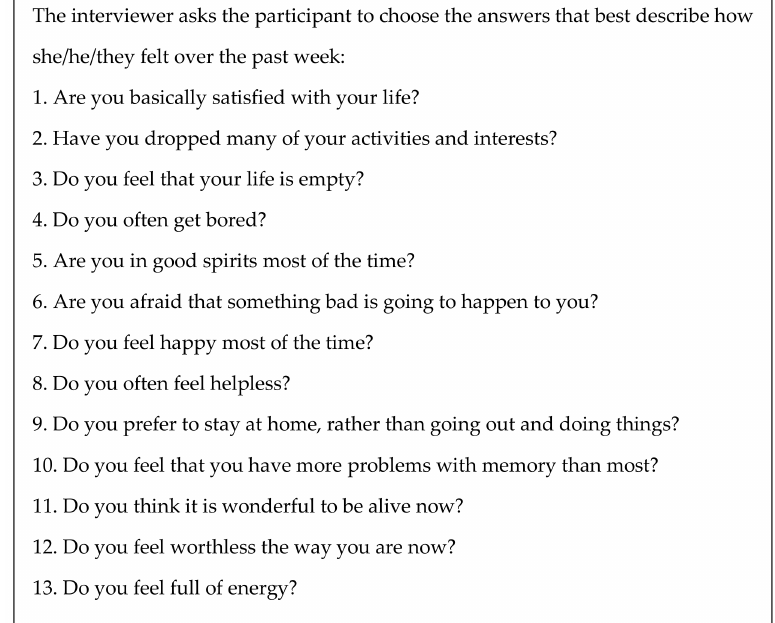
Figure 1. Geriatric Depression Scale—Short Form (Sheikh J.I., Yesavage J.A.,